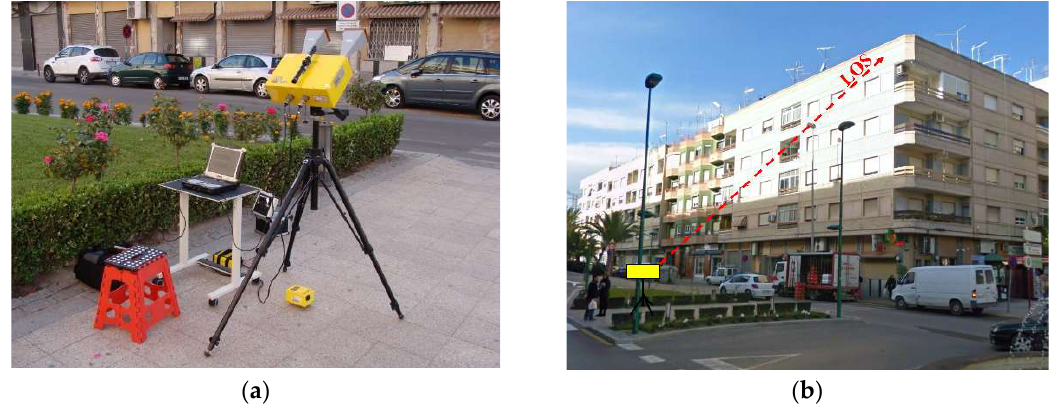
Figure 7. The RAR system ( a ) performing the remote sensing of the top-west (right) corner of the “La Viña” building ( b ). The line of sight (LOS), indicated with a red arrow, is in the T direction.